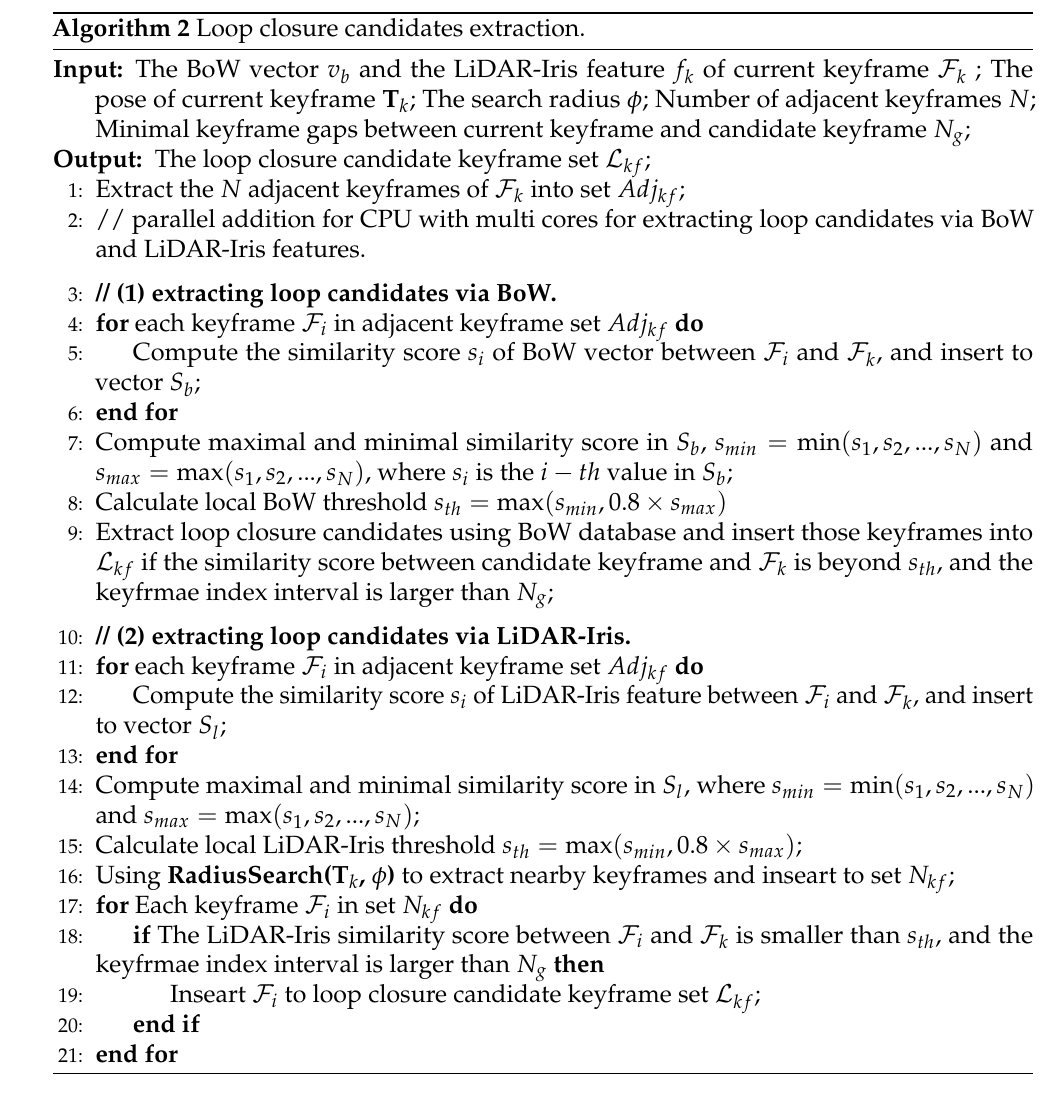
Algorithm 2 Loop closure candidates